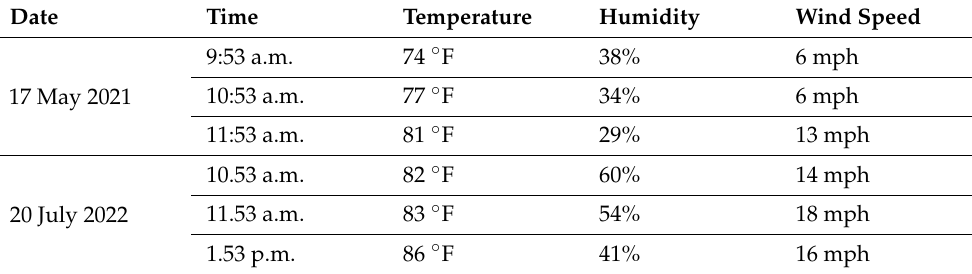
Table 1. Camera specifications. Table 2. Ambient weather conditions during data collection.